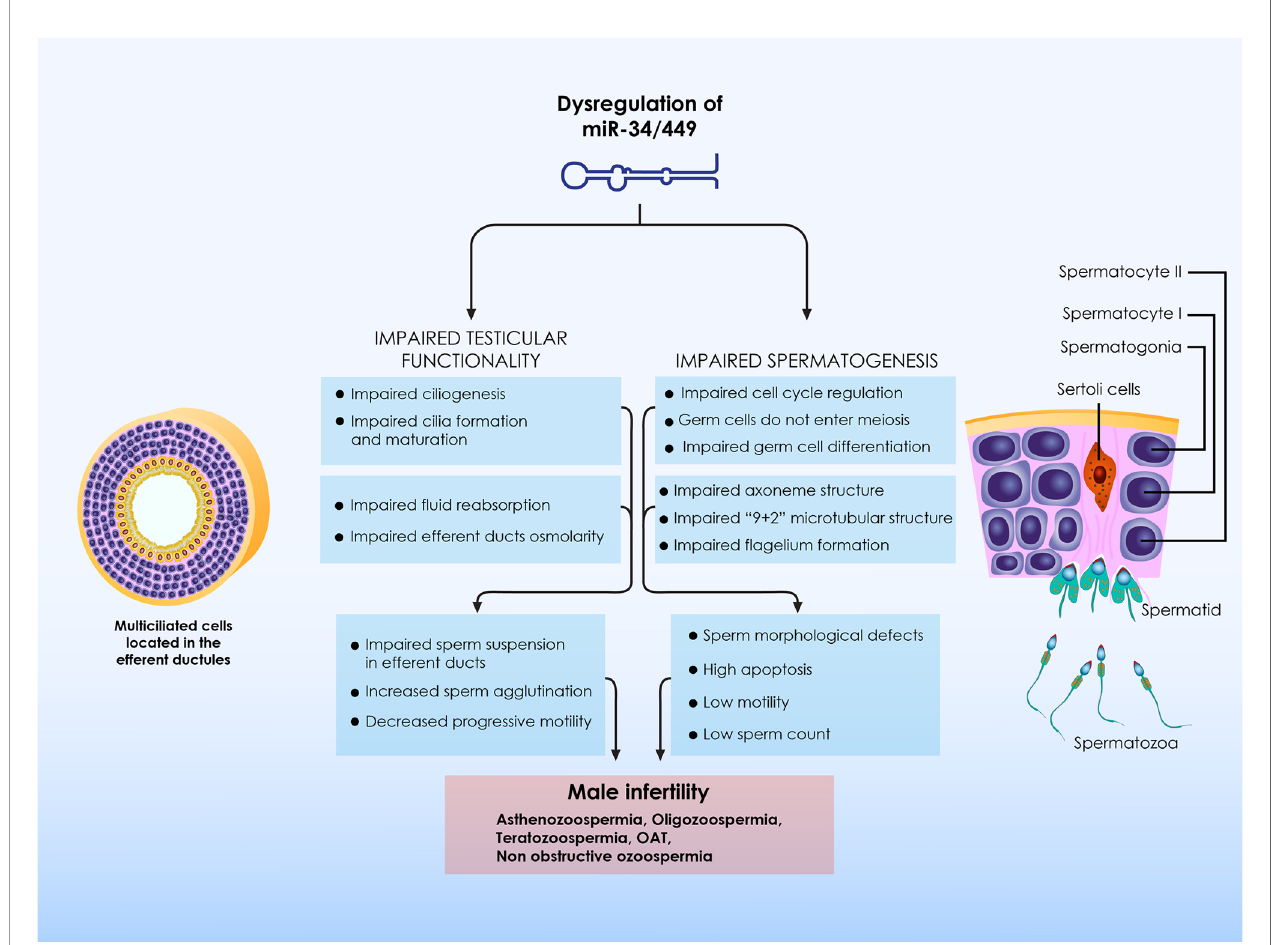
FIGURE 2 | Summary of the role of miR-34/449 on male infertility. Alterations in the expression patterns as well as in functionality of miR-34/449 family members detrimentally affect male reproductive potential, impairing both testicular functionality as well as spermatogenesis per se. On the one hand, impaired miR-34/449 expression patterns result to defective ciliogenesis in the efferent ductules epithelium, leading to impaired reabsorption of the seminiferous tubular fl uids. Failed reabsorption of the fl uids in turns leads to epididymal spermatozoa agglutination and aggregation. In these conditions the number of spermatozoa reaching to caput epididymis is signi fi cantly reduced and as a result the number of mature motile spermatozoa is signi fi cantly decreased causing OAT or even azoospermia. Impaired ciliogenesis also leads to fl uid accumulation into the rete testis, which in turns lead to high hydrostatic pressure into the testis. Hydrostatic pressure progressively leads to spermatogenic failure, fi nally resulting to male infertility. On the other hand, alterations regarding miR-34/449 expression patterns also directly affect spermatogenesis. Upon miR-34/449 dysregulation, the expression patterns of several spermatogenesis-related proteins are disrupted, preventing germ cells to properly enter meiosis and thus to differentiate to mature spermatozoa. Moreover, miR-34/449 dysregulation also directly impairs spermatozoa formation and maturation, mainly considering fl agellum construction and function. Thus, alterations with regard to miR-34/449 expression patterns are directly associated with impaired semen parameters, including abnormal spermatozoa concentration, morphology and motility. OAT, oligoasthenoteratozoospermia